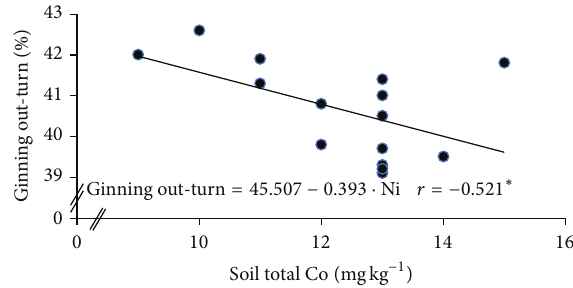
Figure 5: Relationship between Co content of soil and ginning out- turn (%) in the 2003 experiment ( ∗ 𝑝 < 0.05 ).